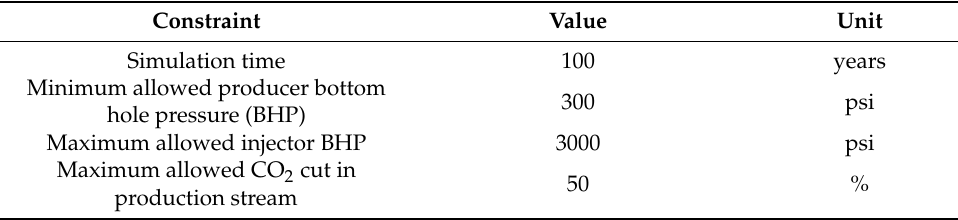
Table A4. Simulation constraints for the 3D reservoir